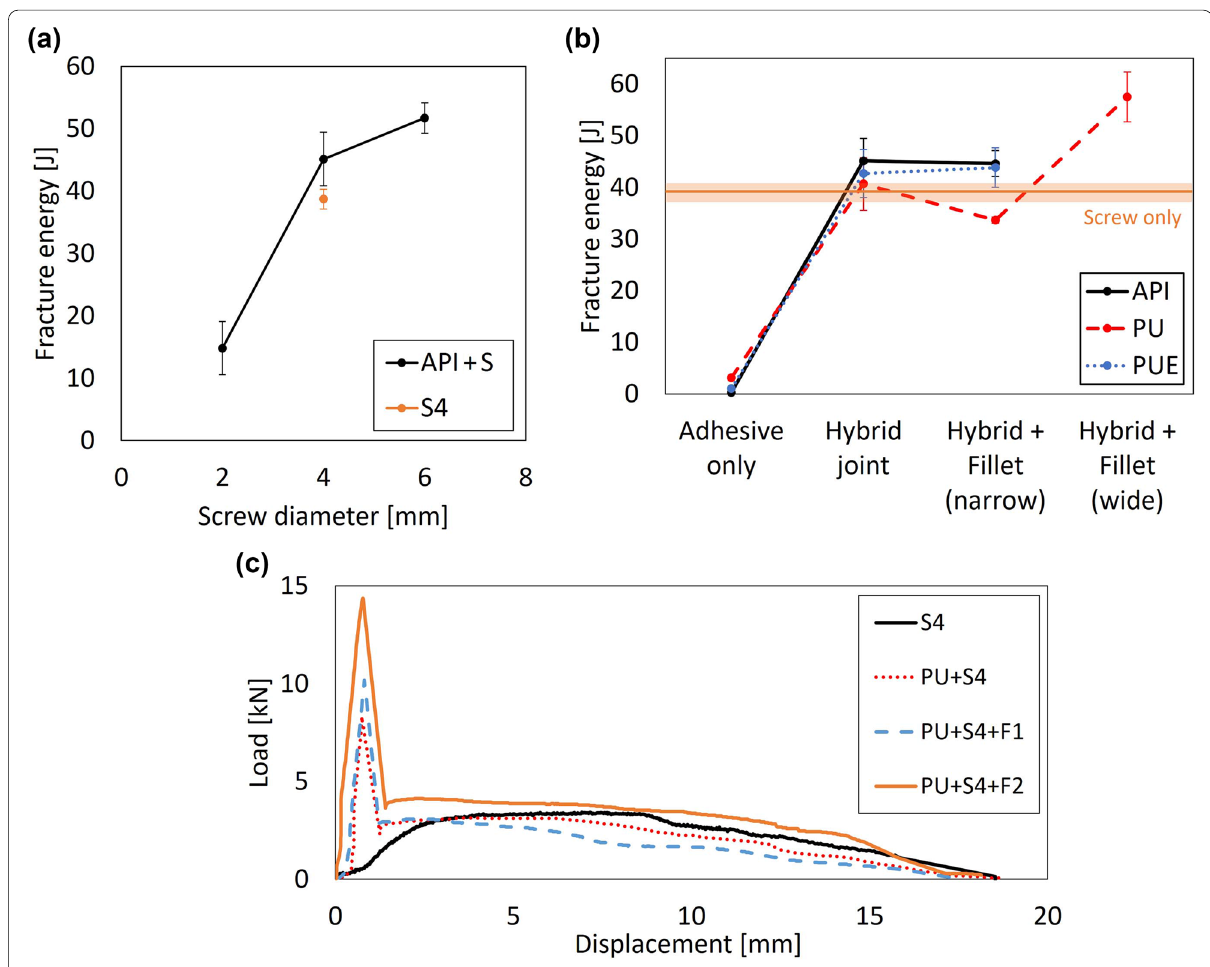
Fig. 8 a Effect of screw diameter on fracture energy (API); b effect of joint type on fracture energy; and c load–displacement curves for the specimens with screws only, the standard hybrid joint, the hybrid joint with a narrow fillet, and the hybrid joint with a wide fillet (PU). Error bars denote standard